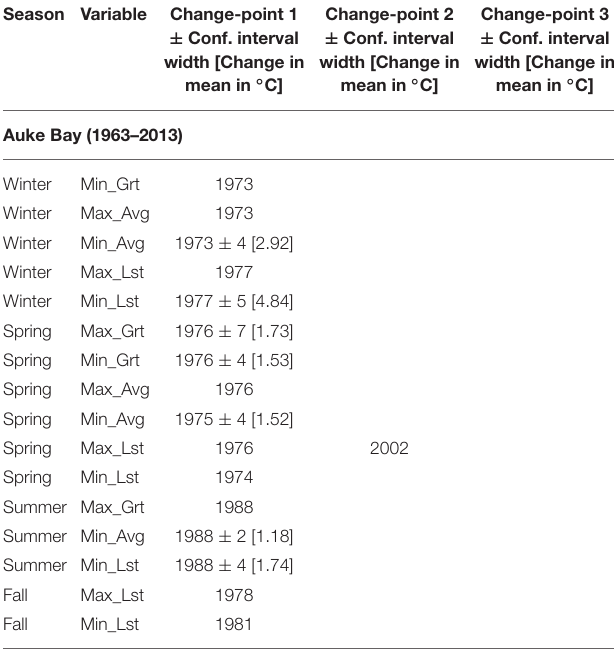
TABLE 4A | Change-points in mean for station AB of Alaska with: PELT change-point estimate ± width of approximate 95% confidence interval (when change detection test p -value < 0.05) and [amount of change in mean in ◦ C], or only PELT change-point estimate (when change detection test p -value > 0.05). Season Variable Change-point 1 ± Conf. interval